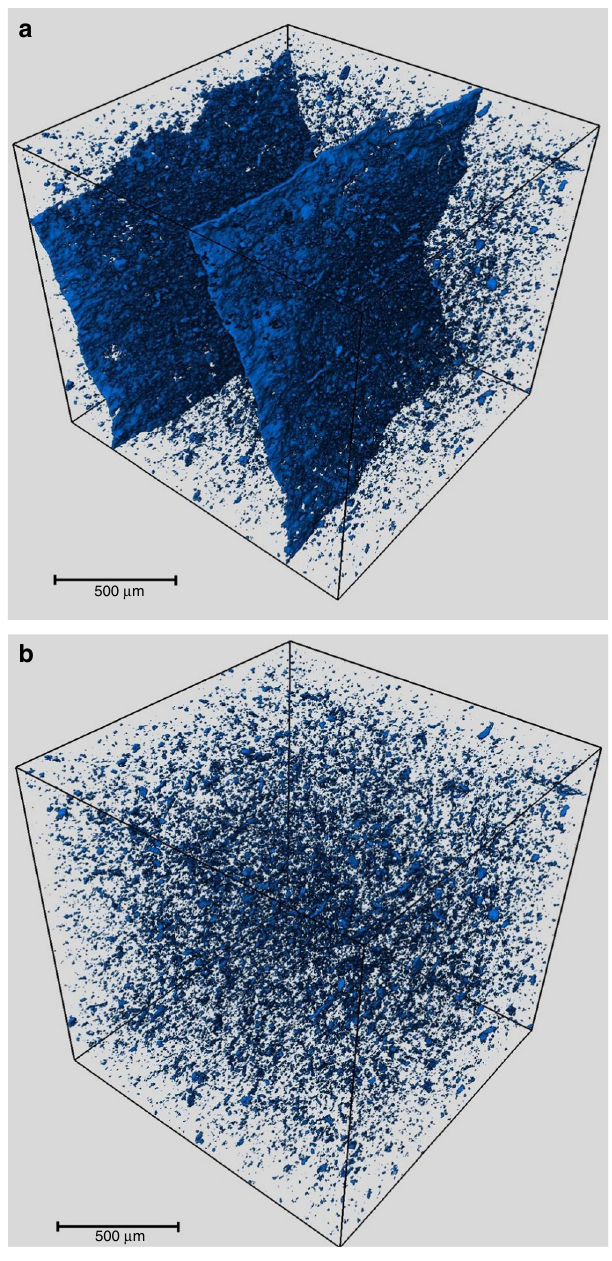
Fig. 5 XRCT pore visualisation for Grange Hill shale sample from stage 5 of the sequential HPWP experiment. a All pores showing the fi ssures induced. b Between 2.75 and 40 µ m, excluding the larger fi ssures for comparison with MIP pore